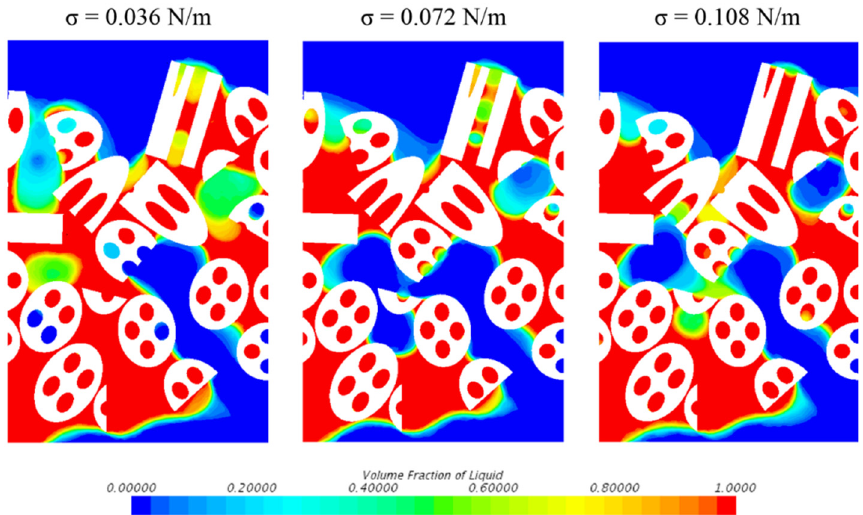
Figure 5. Liquid distributions with three surface tension coefficients ( v G = 0.245 m/s, v L = 0.008 m/s).